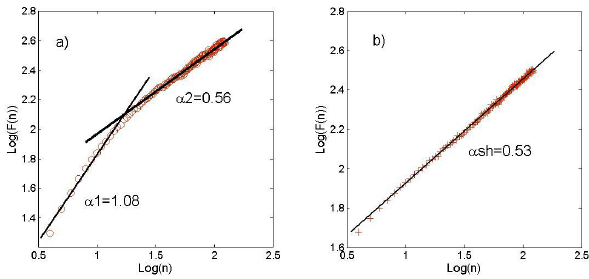
Fig. 6. An example of F(n) ∼ n relationship for ACA2 measured on September 1, 1995. (a) Two scaling regions can be detected, with 1/f dynamics at short scales and white noise dynamics at long scales. (b) F(n) ∼ n relationship for the shuffled series ACA2 measured on September 1, 1995: the correlations are completely destroyed by the shuffling procedure and the scaling exponent is about 0.5.